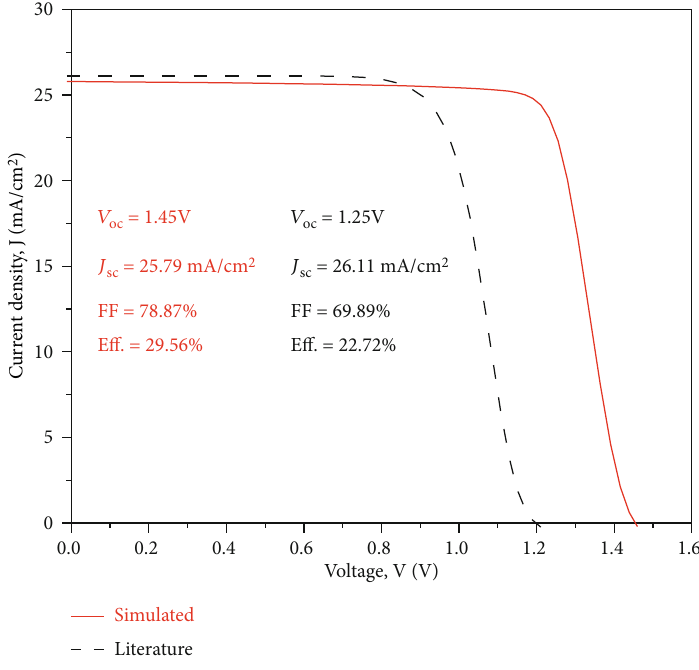
Figure 6: J-V characteristics of the